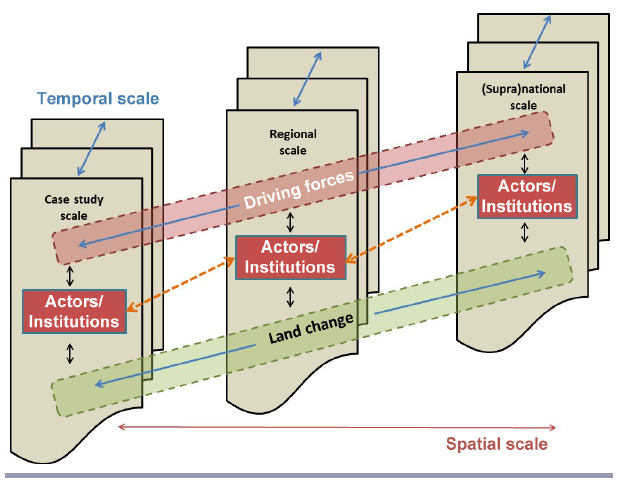
Fig. 1 . Different scales and actors involved in landscape